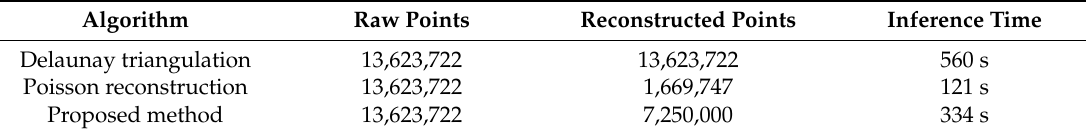
Table 3. Comparison of 50 m tunnel reconstructions by di ff erent algorithms.